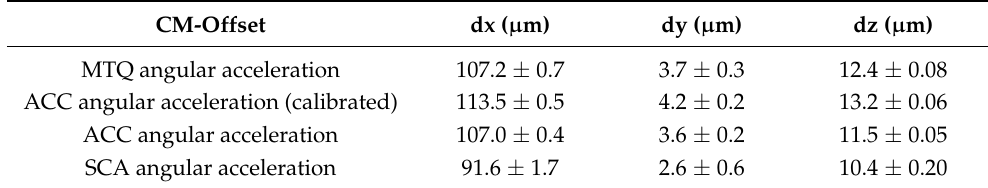
Table 6. Estimation of GRACE-C CM-offset based on four different angular